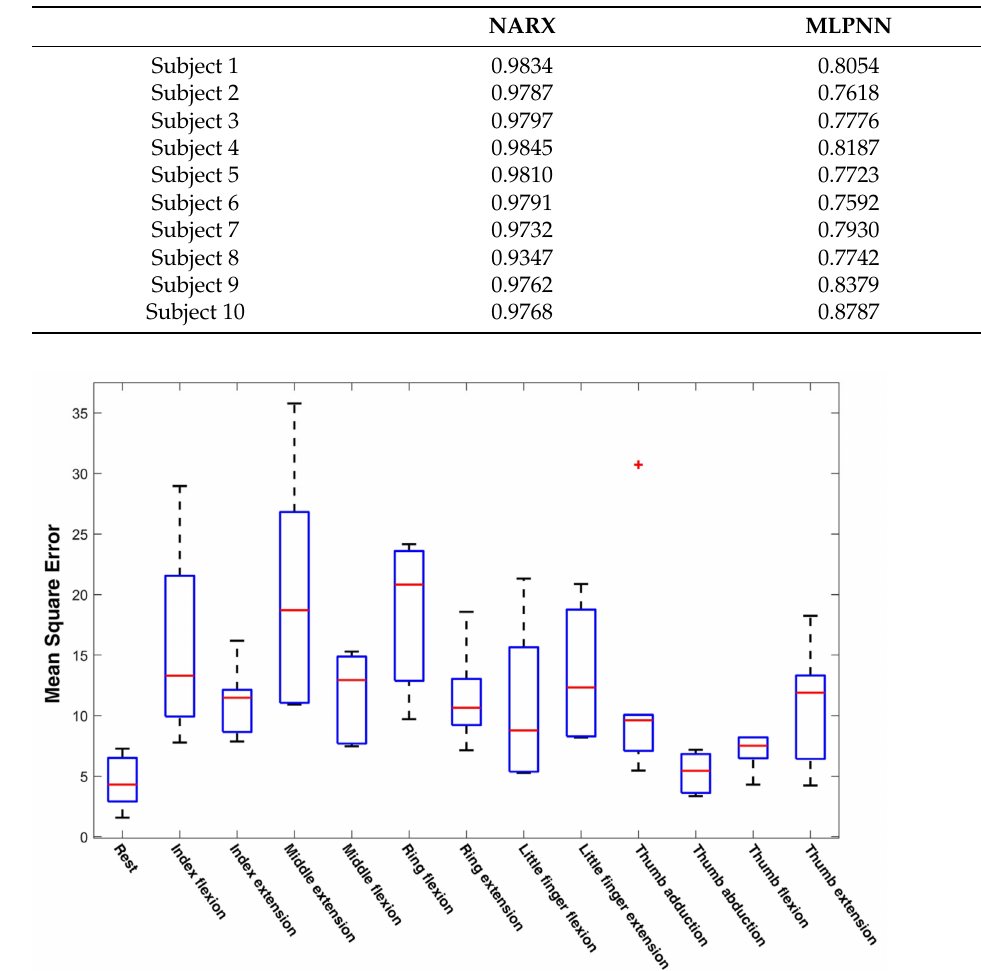
Figure 14. Performance of the proposed model referring to individual movements of